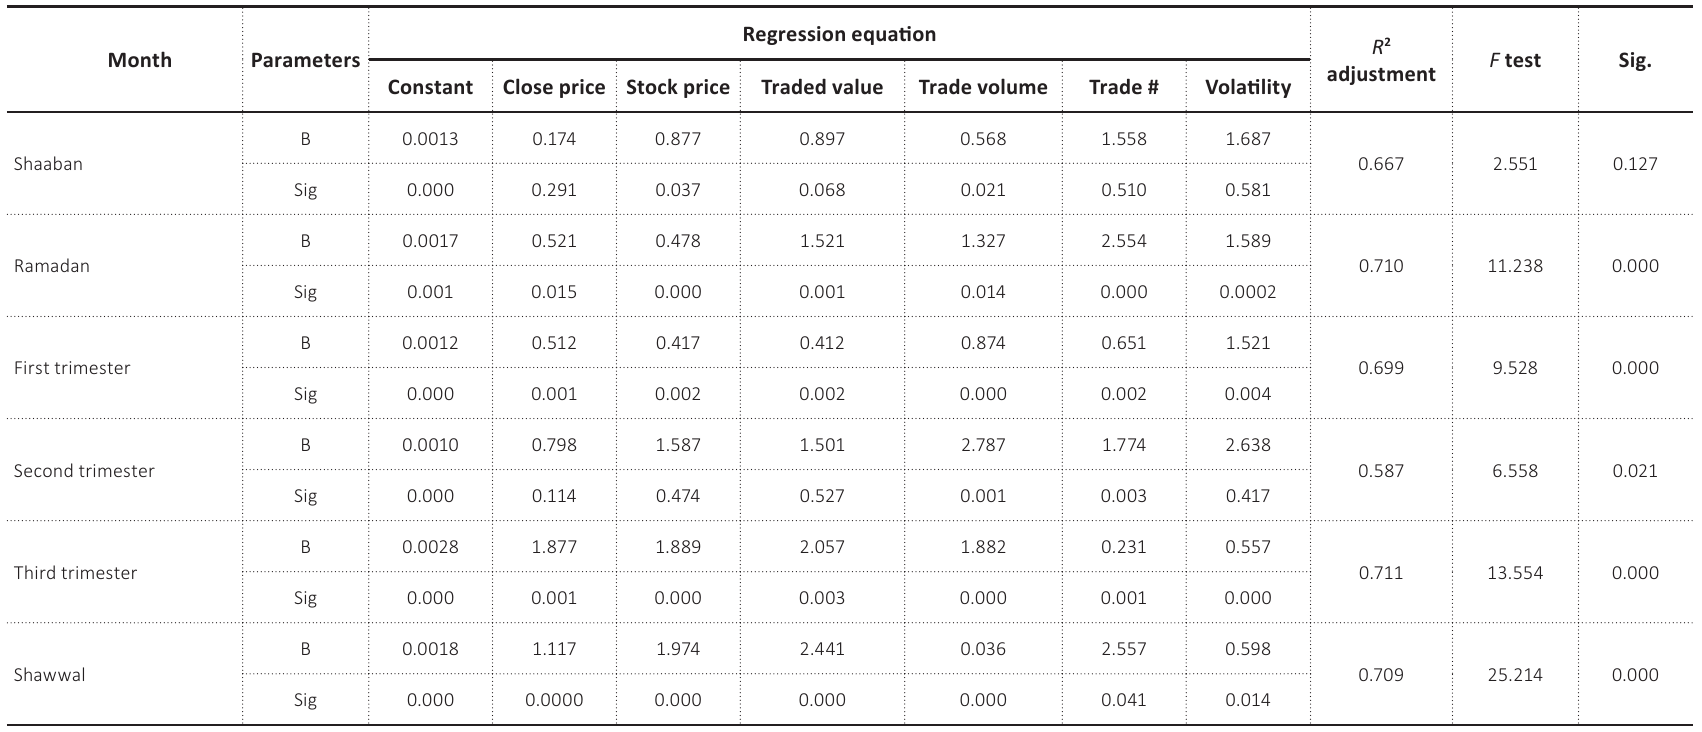
Table 8. Model estimation